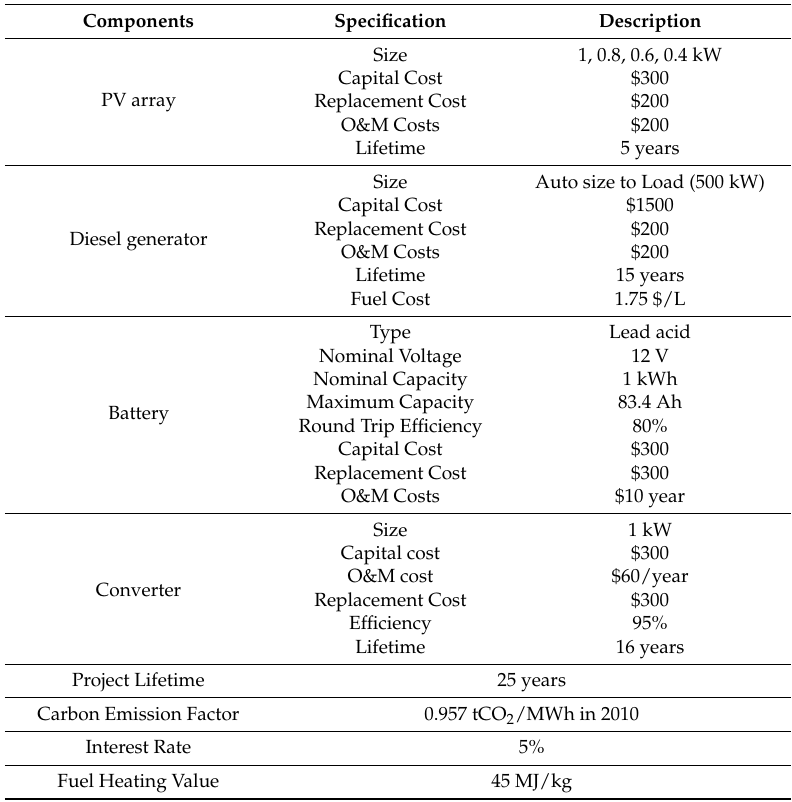
Figure 6. Block diagram of autonomous hybrid PV/diesel generator system/battery storage.